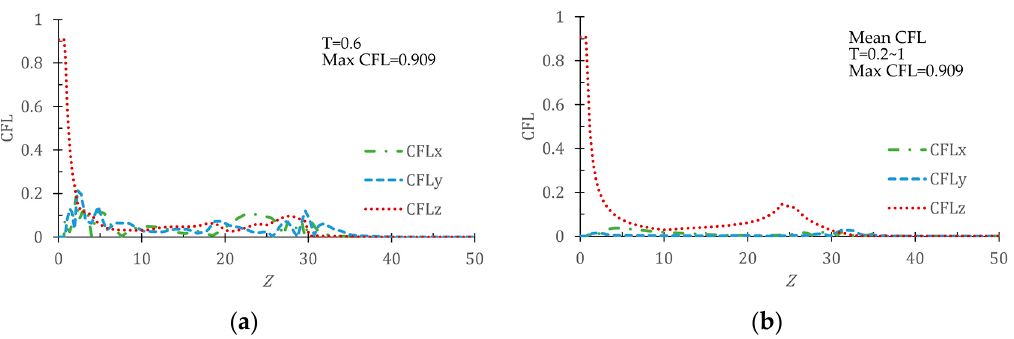
Figure 7. The courant (CFL) number varying with Z at the jet axis. ( a ) Instantaneous CFL. ( b ) Mean CFL.